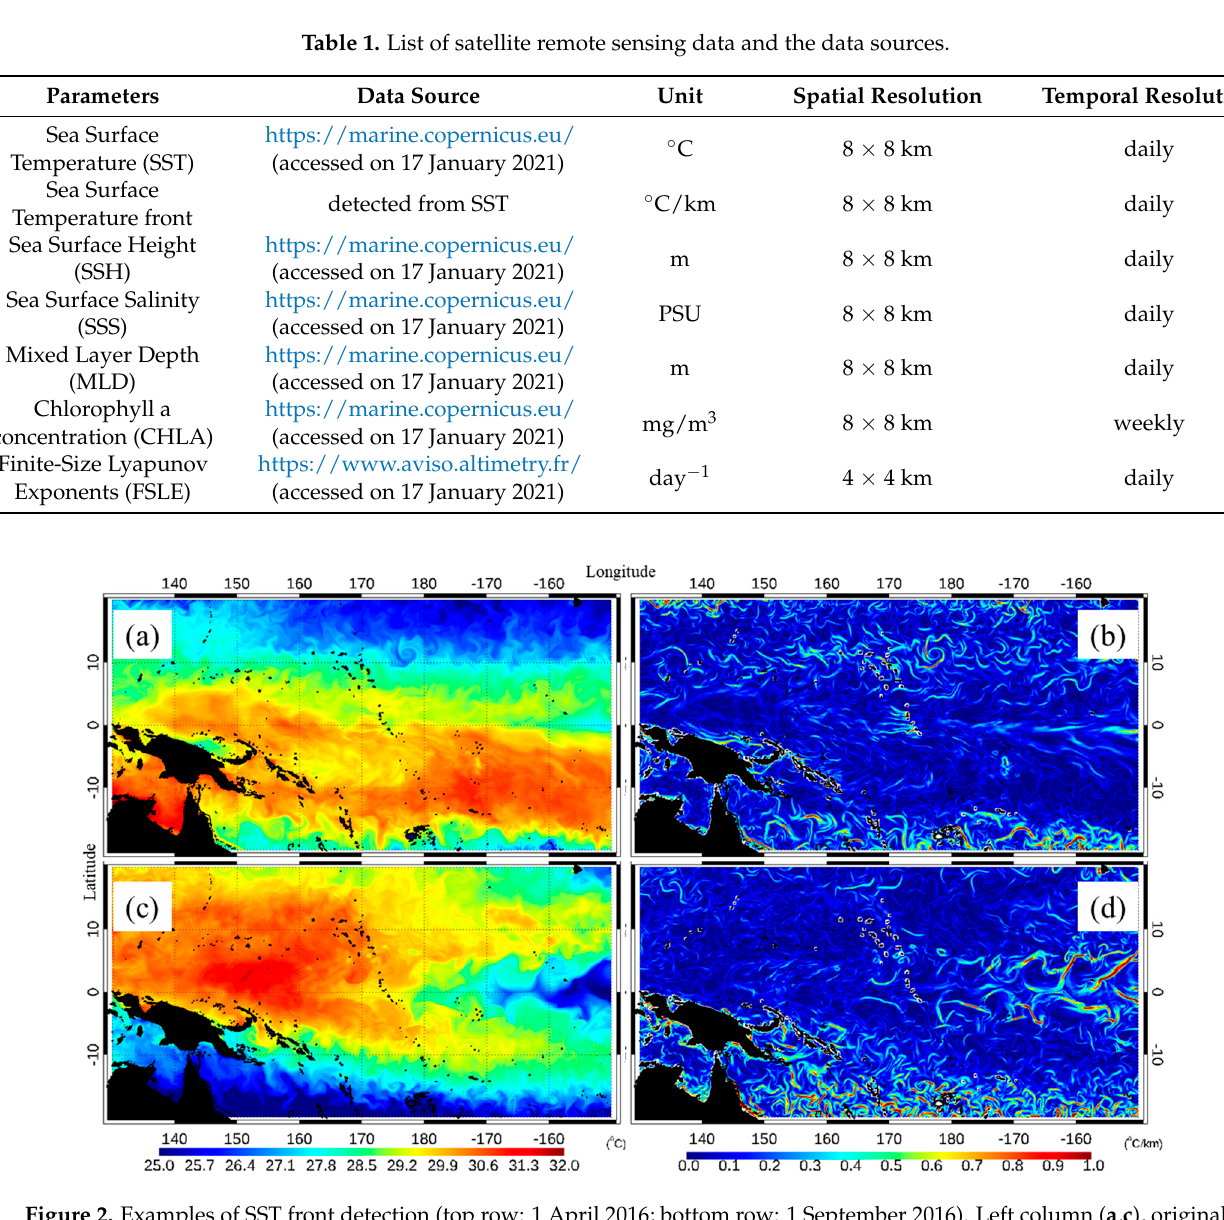
Figure 2. Examples of SST front detection (top row: 1 April 2016; bottom row: 1 September 2016). Left column ( a , c ), original SST images. Right column ( b , d ), gradient images.